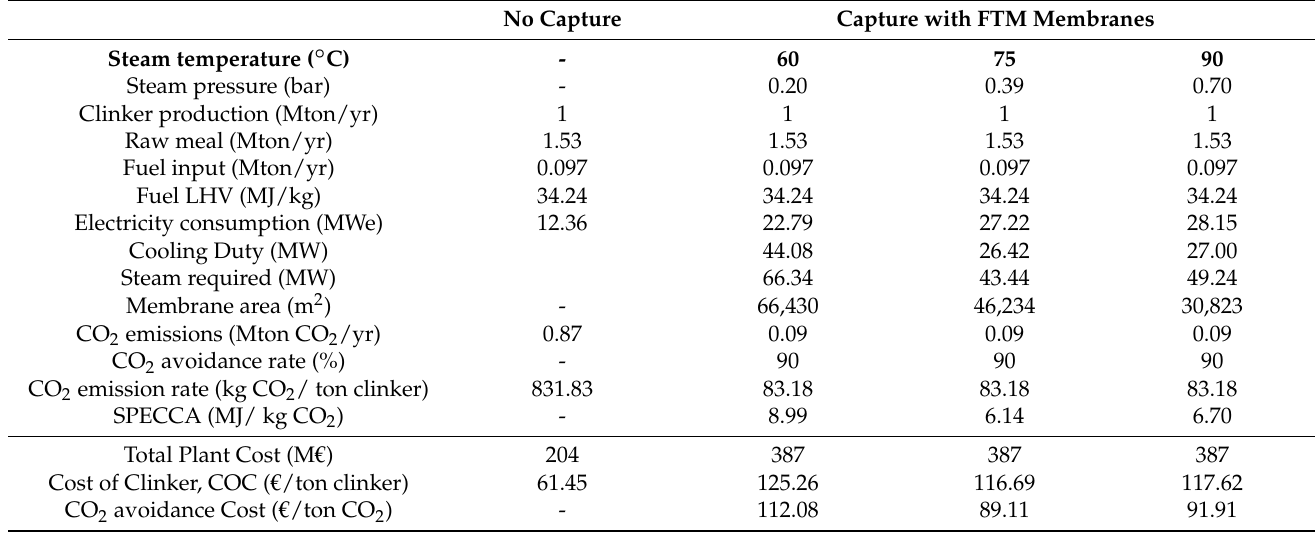
Table 4. Techno-economic performance of cement plant without carbon capture and with carbon capture with FTM membranes using a sweep stream of imported steam at different